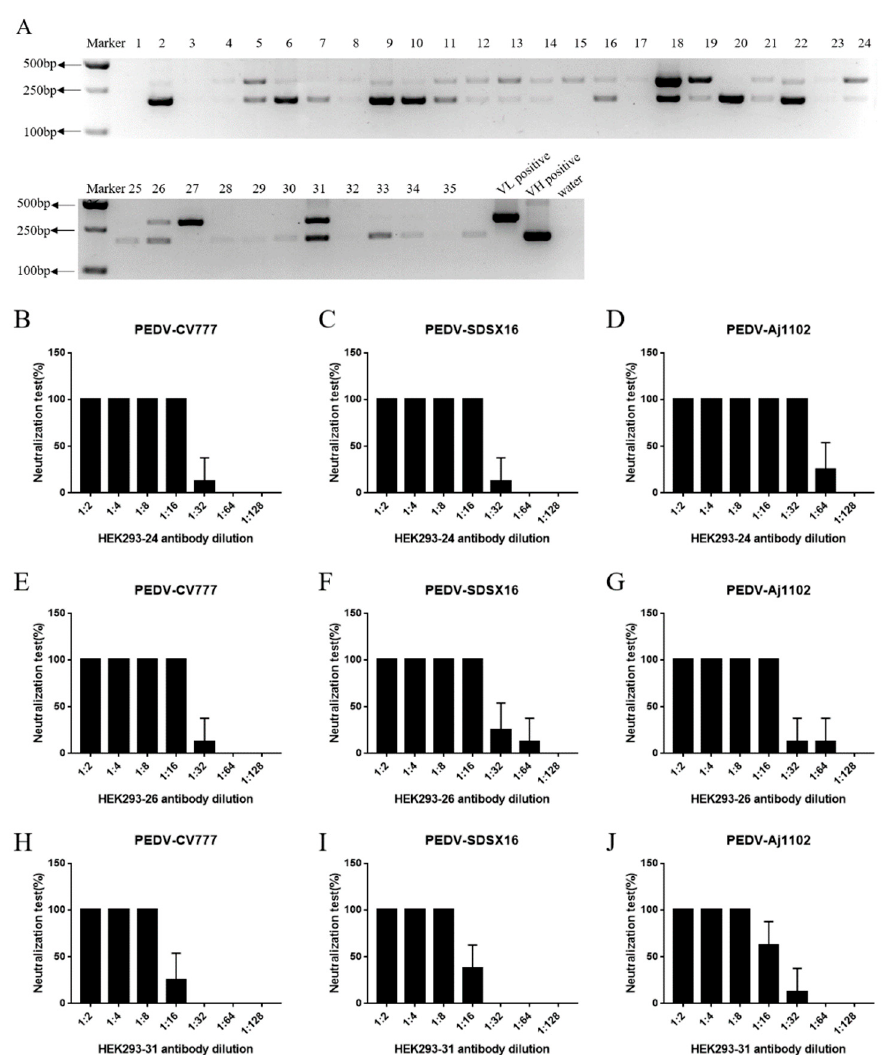
Figure 6. HEK293 cells expressing anti-PEDV mAb-2 genes. ( A ) PCR identification of HEK293 cells expressing VL-Fc at 548 bp and VH-Fc at 410 bp from clones 5, 18, 21, 22, 24, 26, and 31. pCI-anti- PEDV-VL mAb-4 and pCI-anti-PEDV-VH mAb-12 were positive controls. ( B – J ) Neutralization of PEDV-CV777, PEDV-SDSX16 and PEDV-Aj1102 by supernatants from clones 24, 26, and 31.